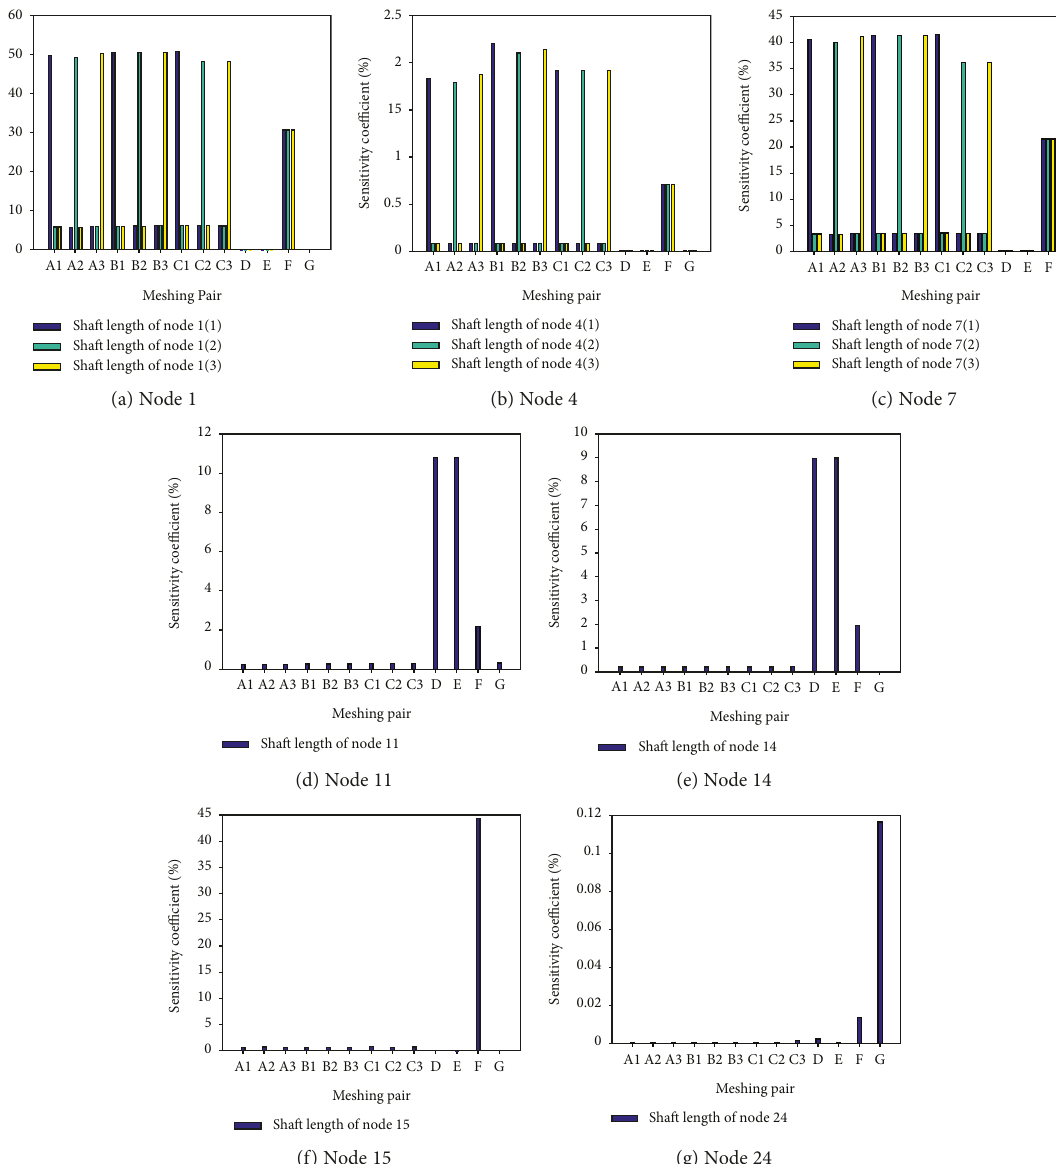
Figure 4: Sensitivity coe ffi cient of each meshing pair in fl uenced by shaft